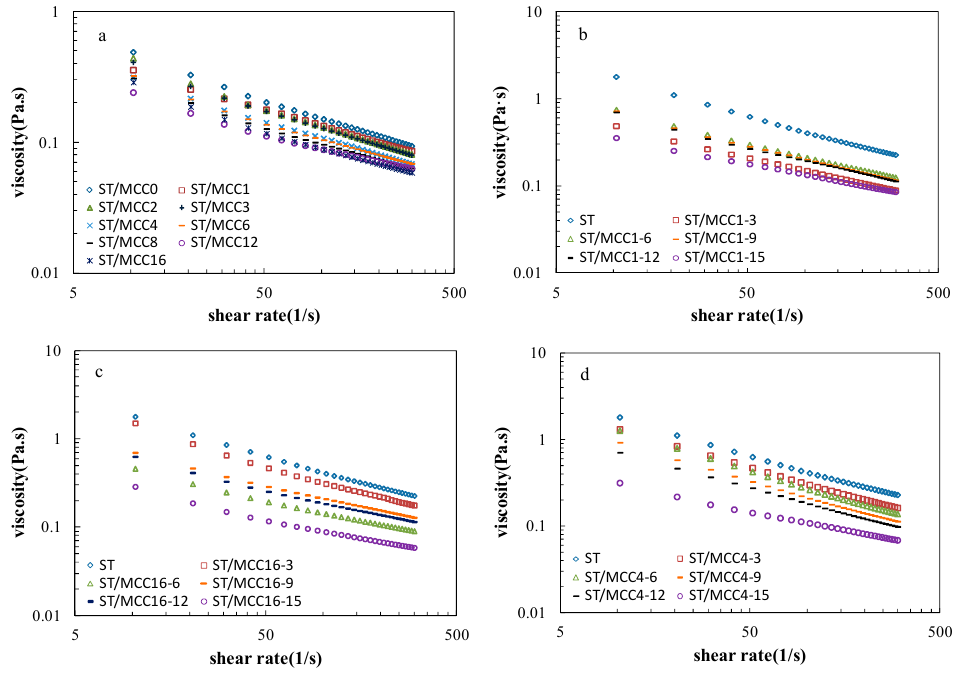
Figure 5. Shear viscosity versus shear rate of ( a ) ST/MCC suspensions with different ball milling times; ( b ) ST/MCC1.0 h suspensions; ( c ) ST/MCC4.0 h suspensions; and ( d ) ST/MCC16.0 h suspensions with concentrations of 15 wt % (purple circles), 12 wt % (black rectangles), 9 wt % (orange rectangles), 6 wt % (green triangles), and 3 wt % (red squares) of the total dry matter weight, and the control (blue diamonds) at 25 °C.